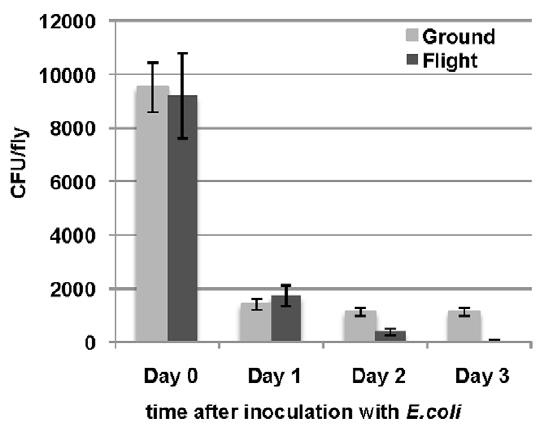
Figure 4. The ability to clear bacterial infections is maintained in adult flies after spaceflight. Adults were infected with E. coli HB101 immediately after return from spaceflight. The overall capacity to clear the bacterial infection was measured by quantifying the live bacteria (CFU) remaining in the animal up to 3 days following infection. Flight adults cleared bacteria as effectively as controls immediately after flight, and more efficiently at days 2 and 3 post infection ( p- value ,